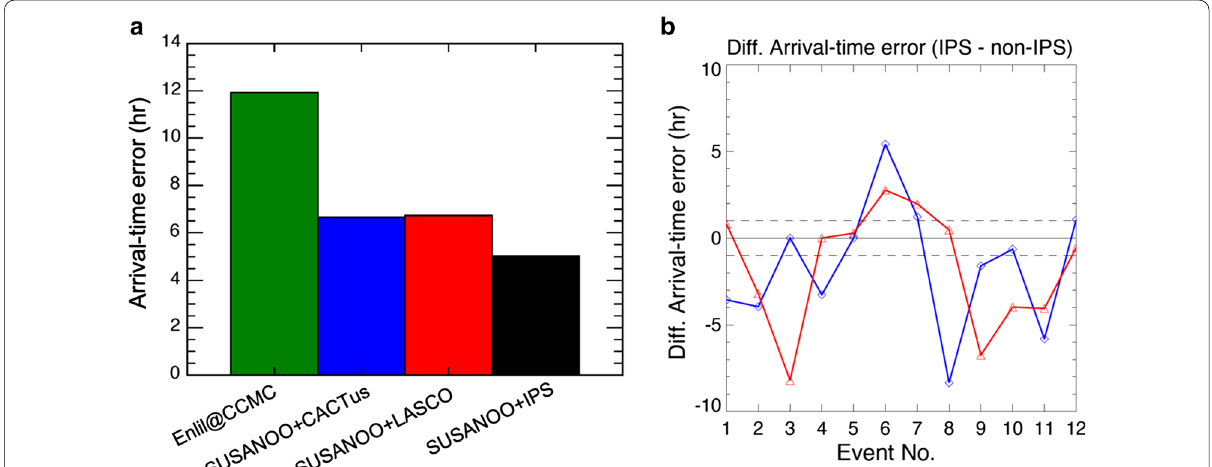
Fig. 3 Arrival-time error of CME at the Earth. a Average of the absolute arrival-time error at the Earth forecasted by the real-time forecast result by GSFC/SWRC archived in the CCMC website (green), and SUSANOO using different CME initial speeds; with initial speeds derived from CACTus (blue), the LASCO catalog (red), and the best fit to IPS data (black). b Difference of the absolute arrival-time error between the SUSANOO simulation that best fit to IPS data and SUSANOO simulation using the initial speeds derived from CACTus (blue) and LASCO (red). The event numbers correspond to the numbers in the first column of Table 1. Dotted lines indicate a 1-h difference, which is equivalent to the error bar of the arrival time in this forecasting method